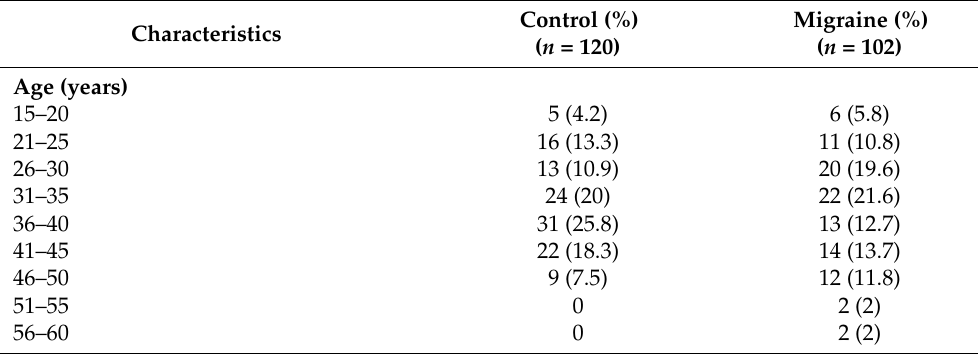
Table 1. Patient and control characteristics of the different